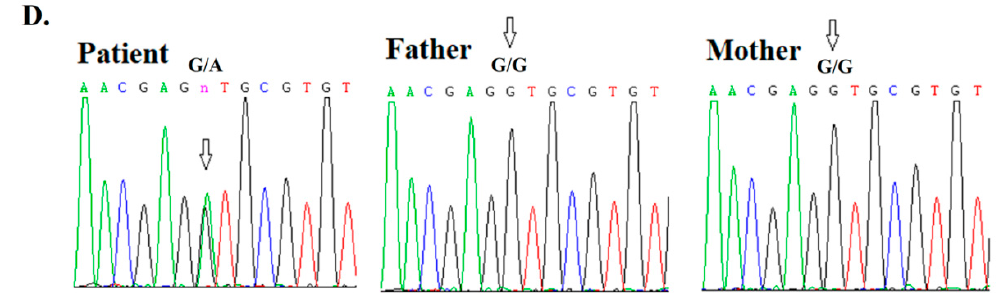
Figure 2. Patient 3 had facial dysmorphic feature, hypotonia, and orogastric tube dependency after birth. ( A ) His toenails were hypoplastic (arrow). Seizure onset occurred at 3 months old. ( B ) Normal toenails in a healthy infant. ( C ) The image of the head ultrasound was unremarkable. ( D ) The WES and sequencing results indicated a novel de novo (no mutation in both parents) mutation in the SMARCA4 gene. The arrow indicates a G-to-A substitution at nucleotide 3595 (c.3595G > A, p.Val1199Met) in the patient (arrow), father, and mother. At 2 years, the patient was not able to sit without support.